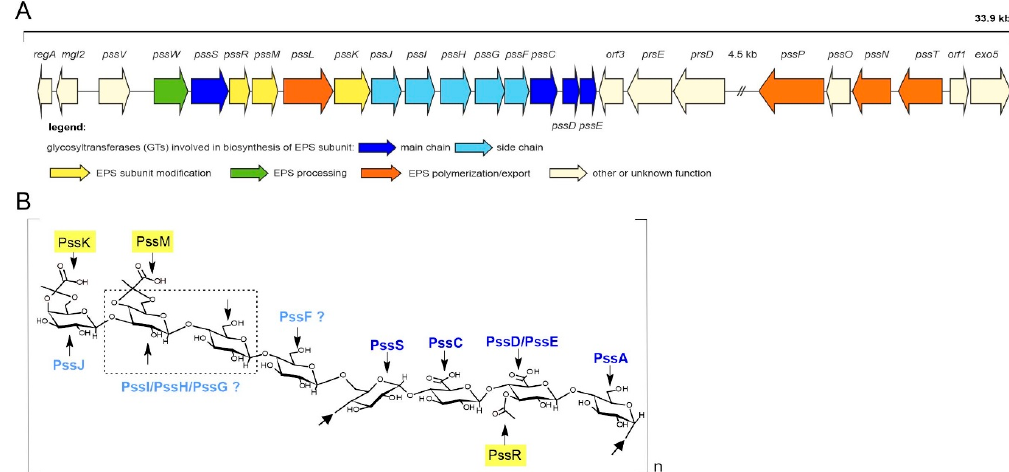
Figure 1. Genetic organization of the Pss-I gene cluster associated with biosynthesis of exopolysaccharide produced by R. leguminosarum bv. trifolii strain TA1 ( A ) and the biological structure of the exopolysaccharide (EPS) repeat subunit ( B ). Linkages, positions of acetyl and pyruvyl substituents, and gene products responsible for adding each sugar or non-carbon modification are shown. The sites of linkage of the backbone were marked with arrows. Colors for glycosyltransferases (GTs) in the map and the structure match. Genes that were previously missing in the RtTA1 Pss-I region are pssH and pssG being part of the cluster of genes encoding side-chain GTs.